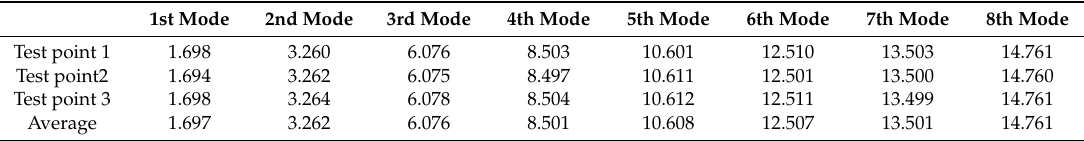
Table 2. Modal frequency in the Y direction of the test points under normal conditions.